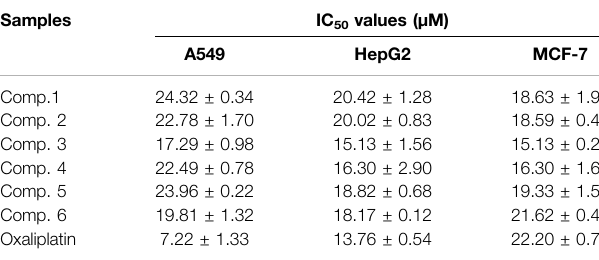
TABLE 2 | Antiproliferative activities of compounds one to six against A549, HepG2, and MCF-7 cell lines.